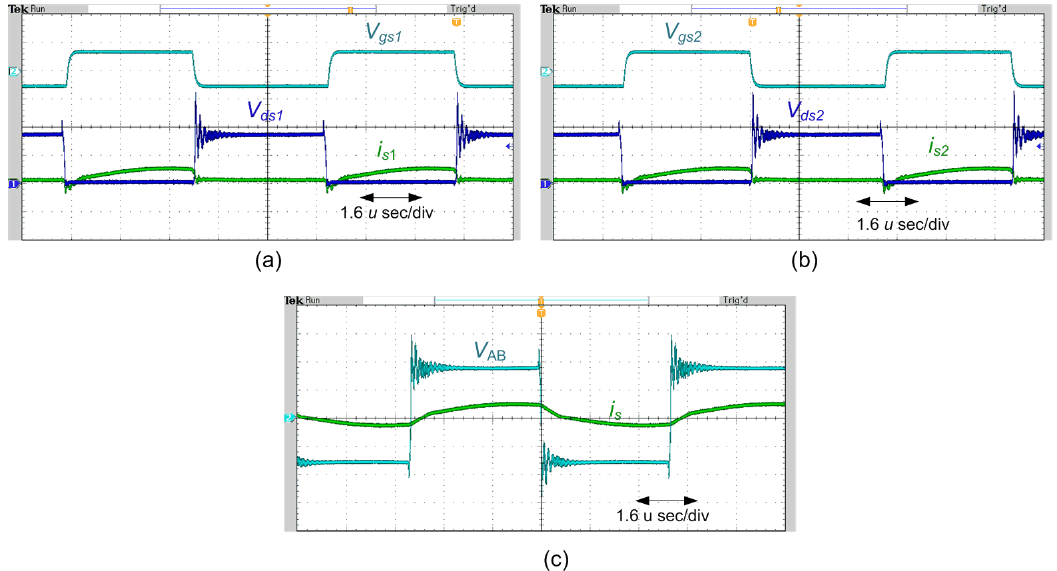
Figure 11. Experimental waveforms at V 1 = 40 V, V 2 = 44 V for 25 Watt load ( a ) V gs 1 : (25 V/div), V ds 1 : (50 V/div), i S 1 : (2 Amp/div); ( b ) V gs 2 : (25 V/div), V ds 2 : (50 V/div), i S 2 : (2 Amp/div); ( c ) V AB : voltage across inverter (25 V/div), i s : resonant current (2 Amp